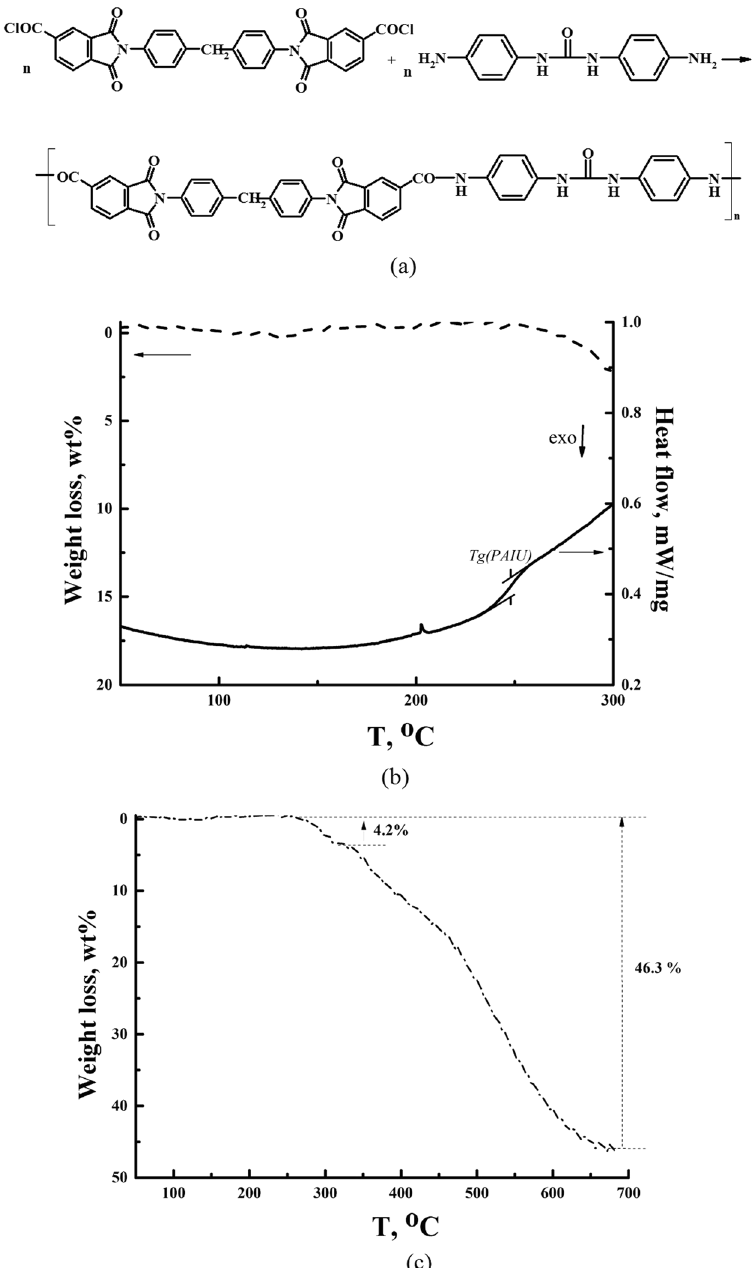
Figure 1. Scheme of PAIU synthesis ( a ), TG ( b , c ) and DSC ( b ) curves of